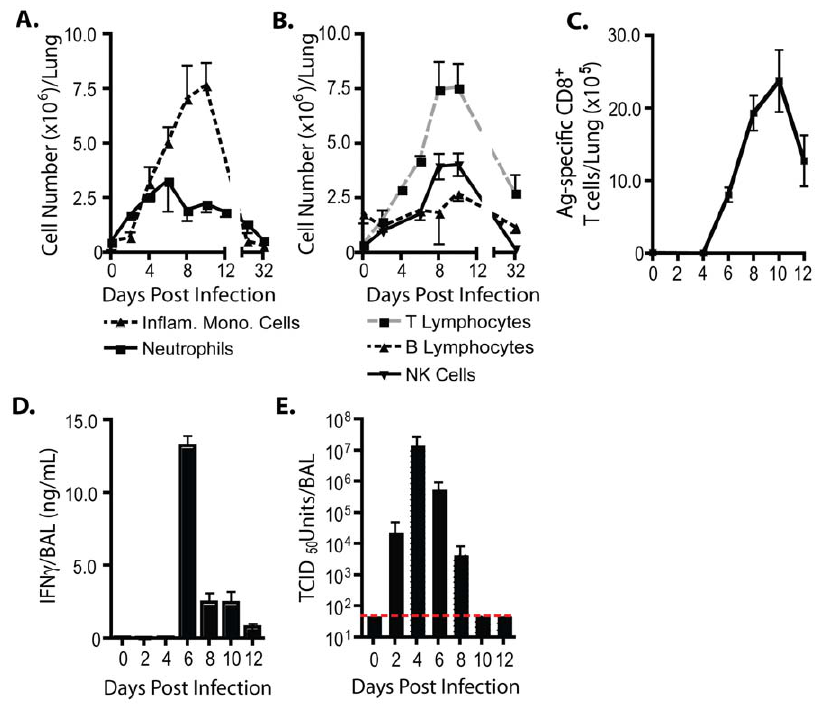
Figure 1. Host immune response to influenza infection. ( A–E ) BALB/c mice were infected with PR8 (0.1LD 50 ) i.n. ( A ) Absolute numbers of neutrophils (solid line) and inflammatory mononuclear cells (dashed line) infiltrating the respiratory tract over time. ( B ) Absolute numbers of lymphocytes (T cells – gray dashes; B cells – black dashes; NK cells – solid lines) infiltrating the respiratory tract over time. ( C ) The number of lung antigen-specific CD8 + T cells was estimated following in vitro re-stimulation with influenza-infected target cells (P815) and analysis of IFN c + CD8 + T cells via flow cytometry. ( D ) IFN c content and ( E ) viral titer in sampled BAL fluid over time. Dashed line signifies limit of viral detection. ( A–E ) Two- three independent experiments (n=2–4/expt) represented as mean 6